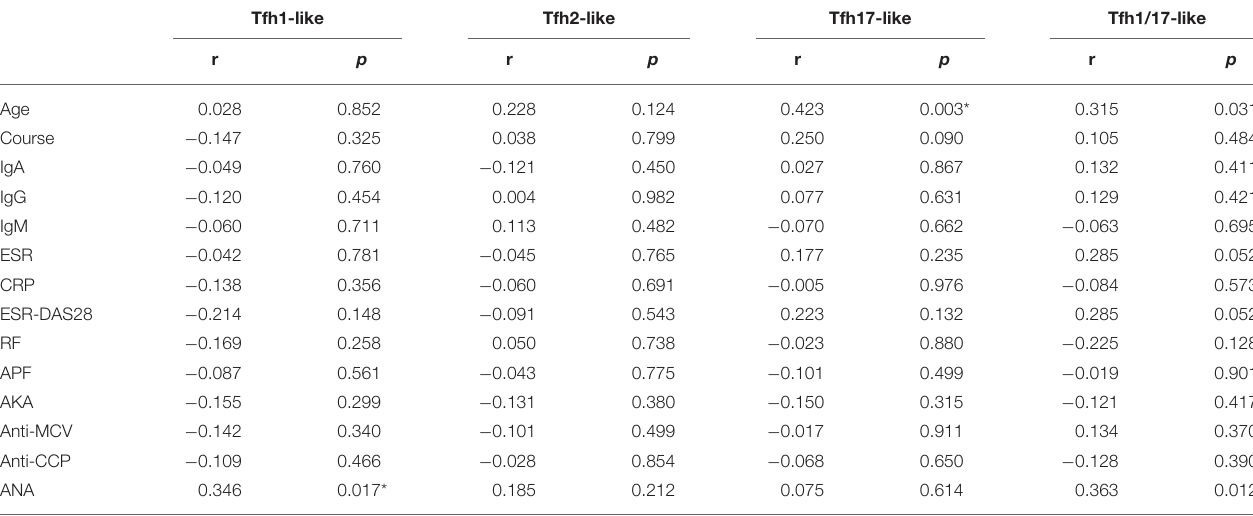
TABLE 2 | Correlations between Tfh-like cell subsets and the clinical and laboratory characteristics of RA patients. Tfh1-like Tfh2-like Tfh17-like